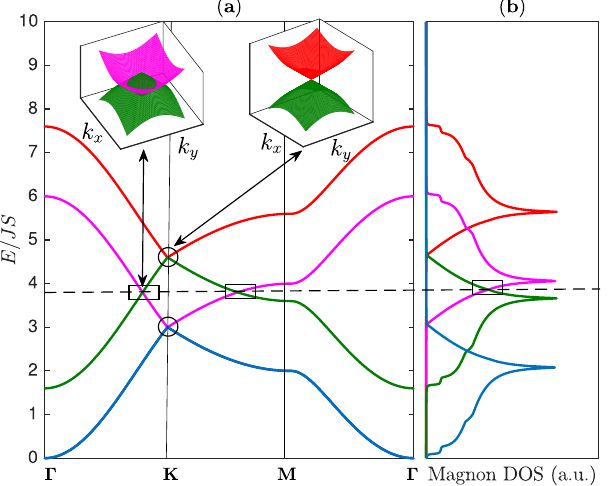
Figure 2. The magnon energy bands and magnon density of states (DOS). ( a ) Magnon band structures with coexistence of magnon Dirac-nodal lines (rectangular boxes) and magnon Dirac points (circles) along the Brillouin zone paths in Fig. 1(b). The dashed line corresponds to the energy of Dirac magnon-nodal lines at E = E 0 . The inset shows the 3D bands near K for the Dirac magnon-nodal lines and Dirac magnon points respectively as indicated by the same colour codes of the 2D bands. ( b ) The corresponding magnon density of states (DOS). The plots are generated by setting J L = 0.8 J .